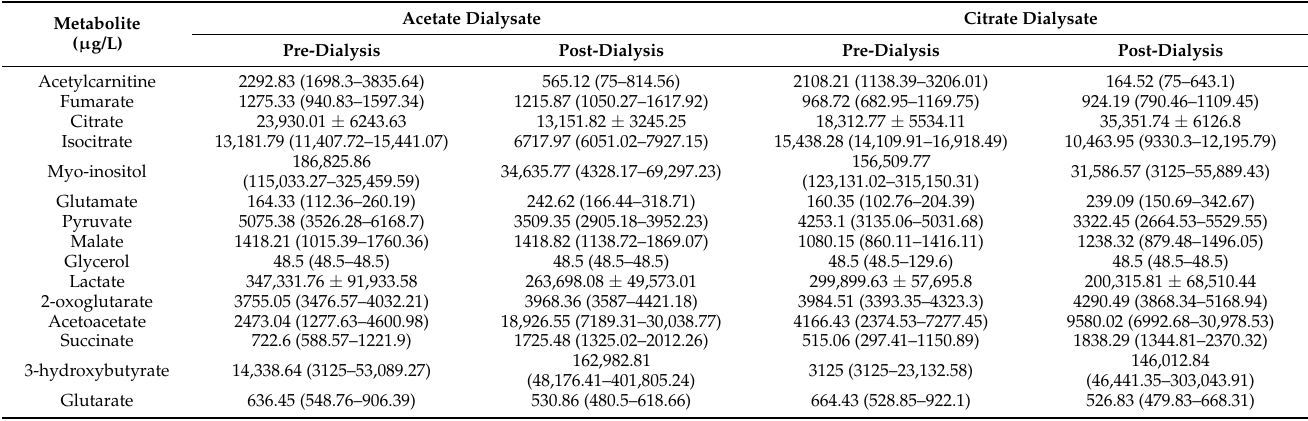
Table 1. Differences in measured metabolites concentrations expressed in µ g/L as mean ± standard deviation or median (interquartile